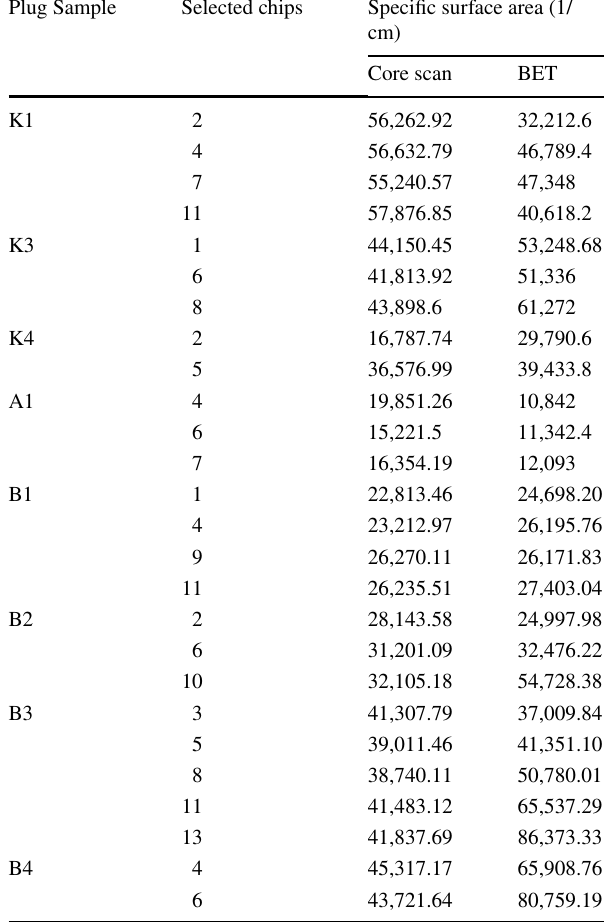
Table 7 Specific surface area of selected chips by core scan and BET Plug Sample Selected chips